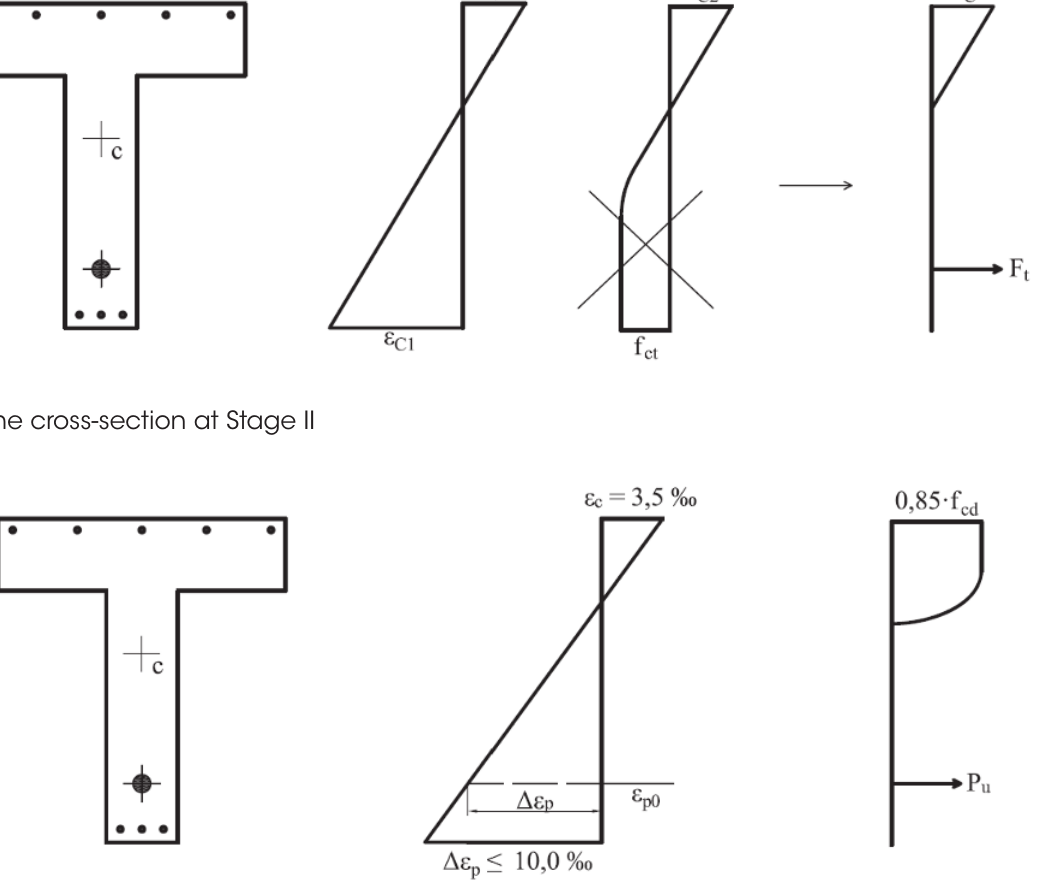
Stresses in the cross-section at Stage III for concrete class up to